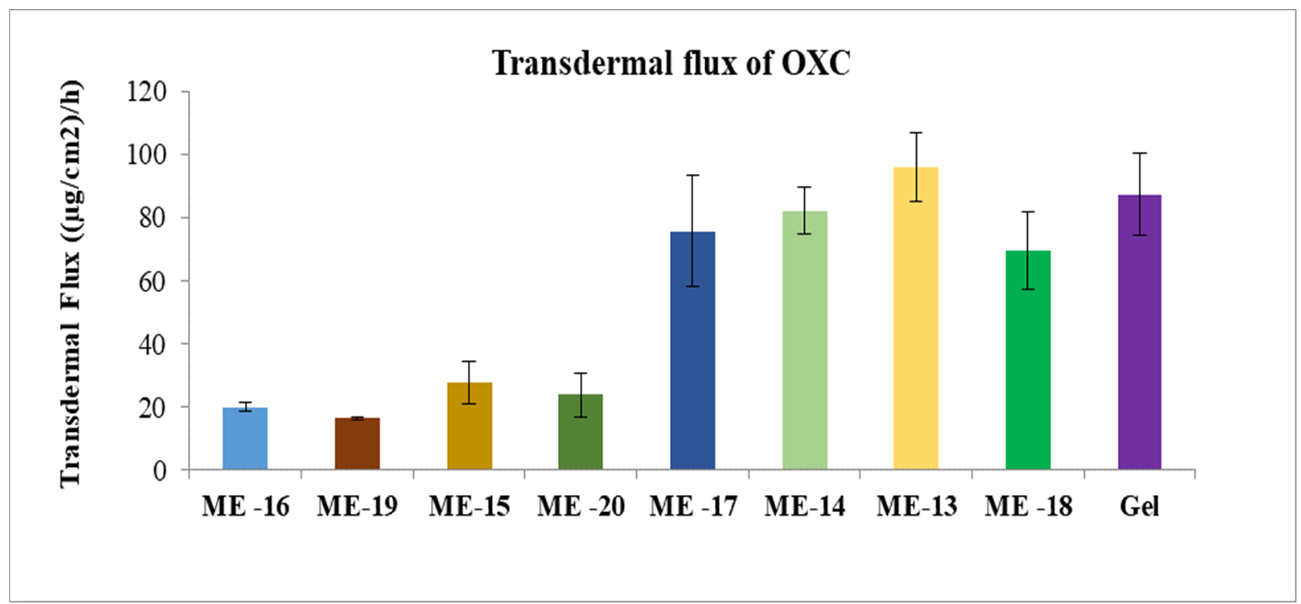
Figure 11. Transdermal flux of OXC across the human cadaver skin from microemulsions. Each point represents the mean ± S.D. of three replicates in the absence of multiple donors.